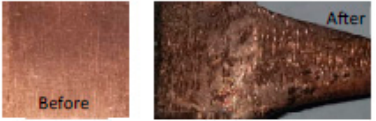
Figure 14. Before and after on cathode electrode.